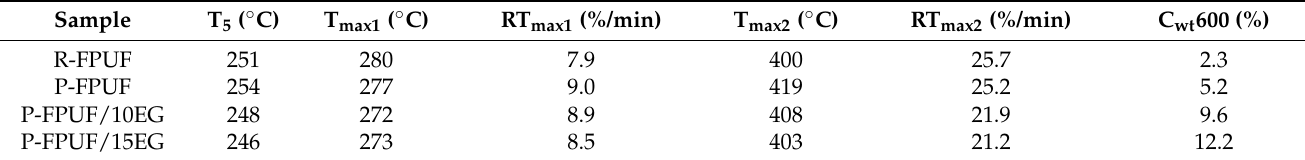
Table 3. TGA data of FPUFs at a heating rate of 20 ℃ /min in N 2 .